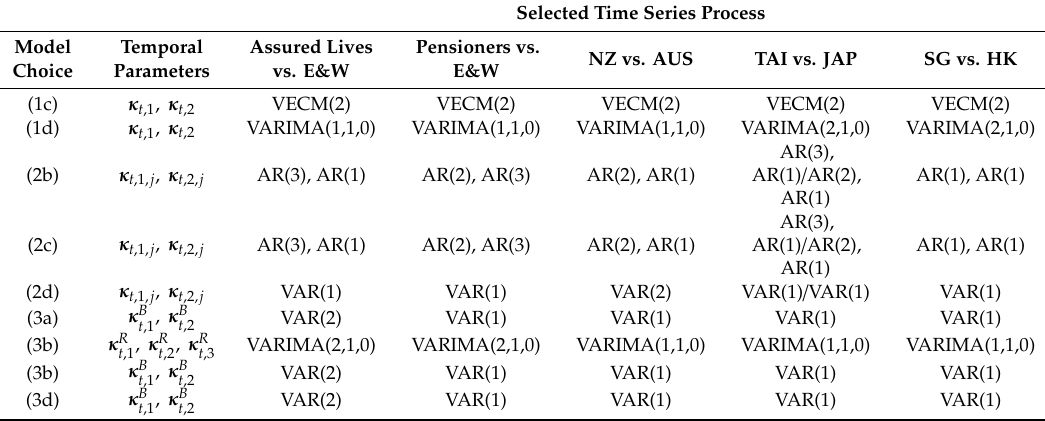
Table 3. Selected orders of fitted time series processes under di ff erent mortality projection models for di ff erent